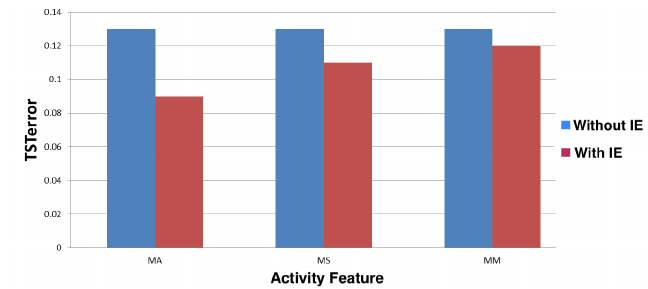
Figure 6. Effect of image enhancement (IE) for the performance improvement of the error of total sleep